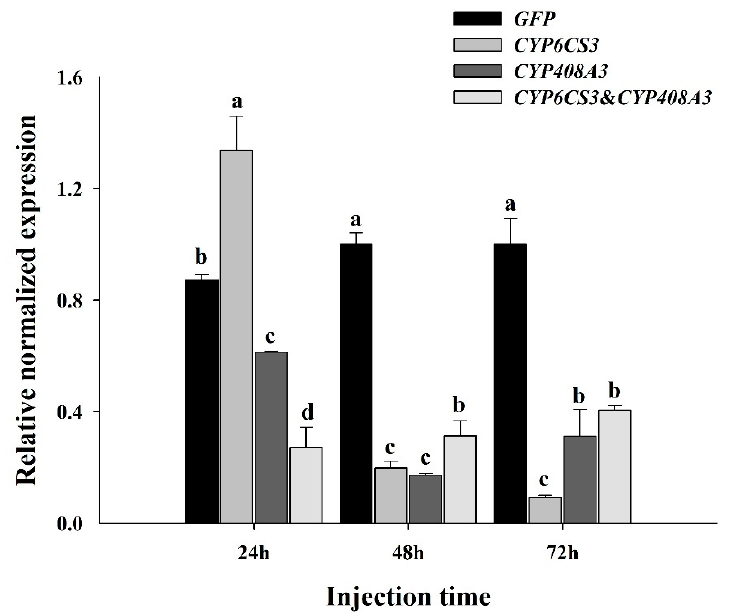
Figure 5. Functional analysis of CYP6CS3 and CYP408A3 by RNAi. The relative expression of CYP6CS3 and CYP408A3 in the fourth instar nymphs injected with dsCYP6CS3 , dsCYP408A3 , or the mixture of dsCYP6CS3 and dsCYP408A3 in each period compared with dsGFP . Significant differences are indicated by different letters, for example, a, b, c, and d ( p < 0.05, with a Student’s t -test).